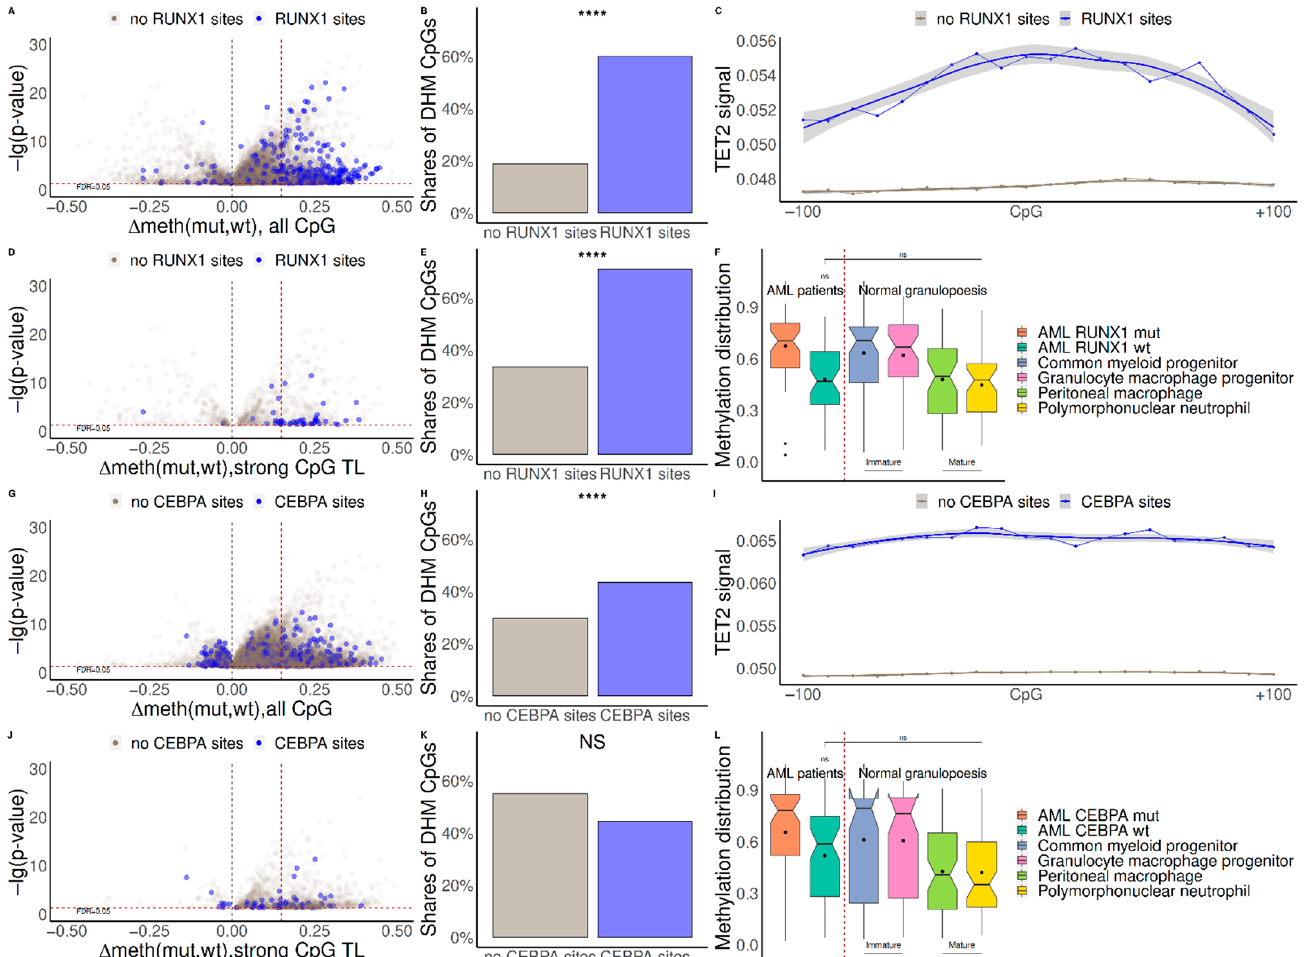
Figure 1. ( A , D , G , J ): Difference in the average levels of DNA methylation between AML patients with and without RUNX1/CEBPA mutation ( Δ meth). Differentially methylated CpG in close proximity to TFBS and the rest of the differentially methylated CpGs are represented as purple and gray dots, respectively. Changes in DNA methylation genome-wide and near CpG TL are represented in panels ( A , G ) for RUNX1 and ( D , J ) for CEBPA, respectively. ( B , E , H , K ): Proportions of hypermethylated CpGs near TFBS (purple) and in the rest of the genome (gray) in patients with mutated RUNX1/CEBPA. Proportions of hypermethylated genome-wide and near CpG TLs are represented in panels ( B , H ) and ( E , K ), respectively. Significant differences ( p -value < 10 − 7 ) are marked by ****, insignificant difference is marked by NS. ( C , I ) TET2 binding around hypermethylated CpG near RUNX1/CEBPA TFBS (purple) and in the rest of the genome (gray). ( F , L ) Average methylation levels of strong CpG TL near RUNX1/CEBPA TFBS in different stages of normal hematopoiesis and in AML patients with or without the corresponding